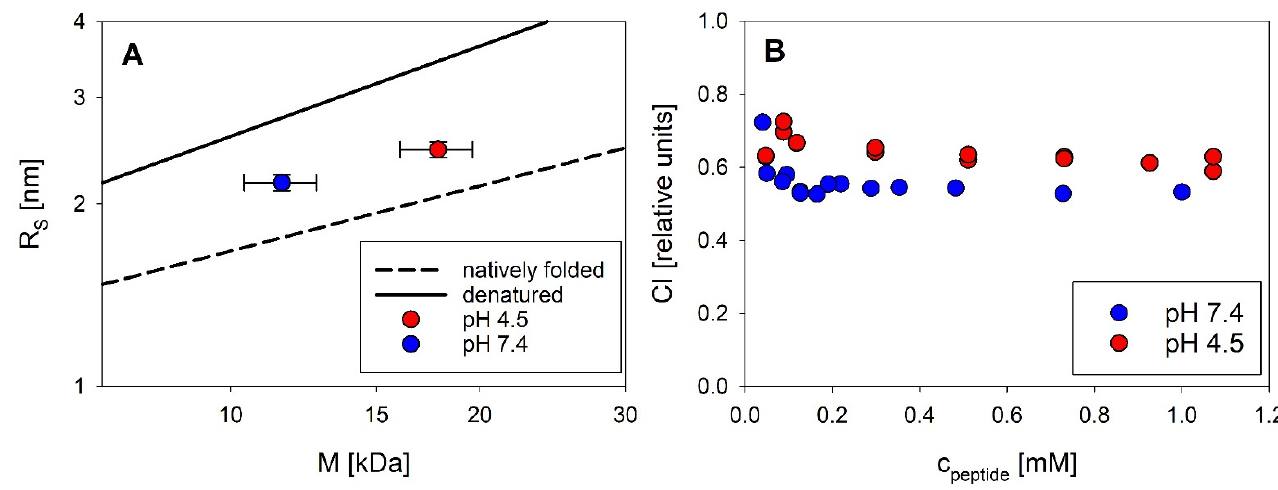
Figure 10. Compactness of exendin-4 at pH 7.4 (blue) and pH 4.5 (red). Compactness of ~0.3 mM exendin-4 at 23 °C, visualized using scaling laws of the type R S = aM b with a scaling exponent b of 0.33 for globular and of 0.5 for denatured proteins, respectively. Error bars indicate average experimental errors of 10 and 3% for the apparent molecular mass and R S , respectively. Reference data sets reporting on the average compactness of natively folded (dashed line) and denatured (solid line) proteins are shown for comparison ( A ). CI were calculated as compactness relative to the scaling behavior of unfolded and folded reference proteins, assuming CI of 0 and 1, respectively ( B ).